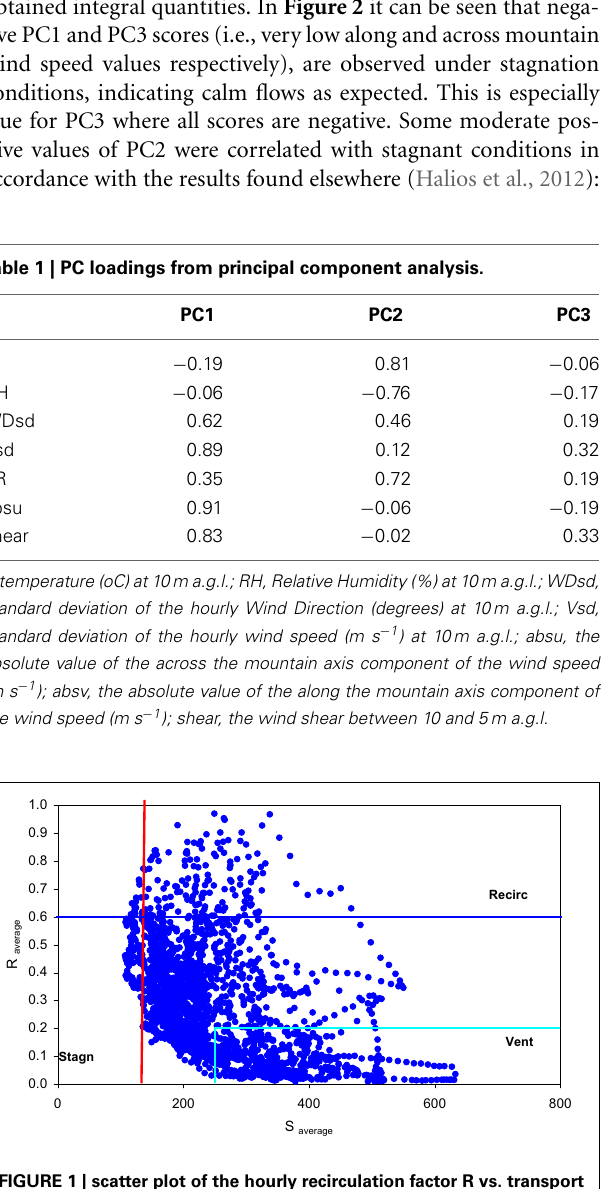
FIGURE 1 | scatter plot of the hourly recirculation factor R vs. transport distance S and the corresponding classification according to Allwine and Whiteman